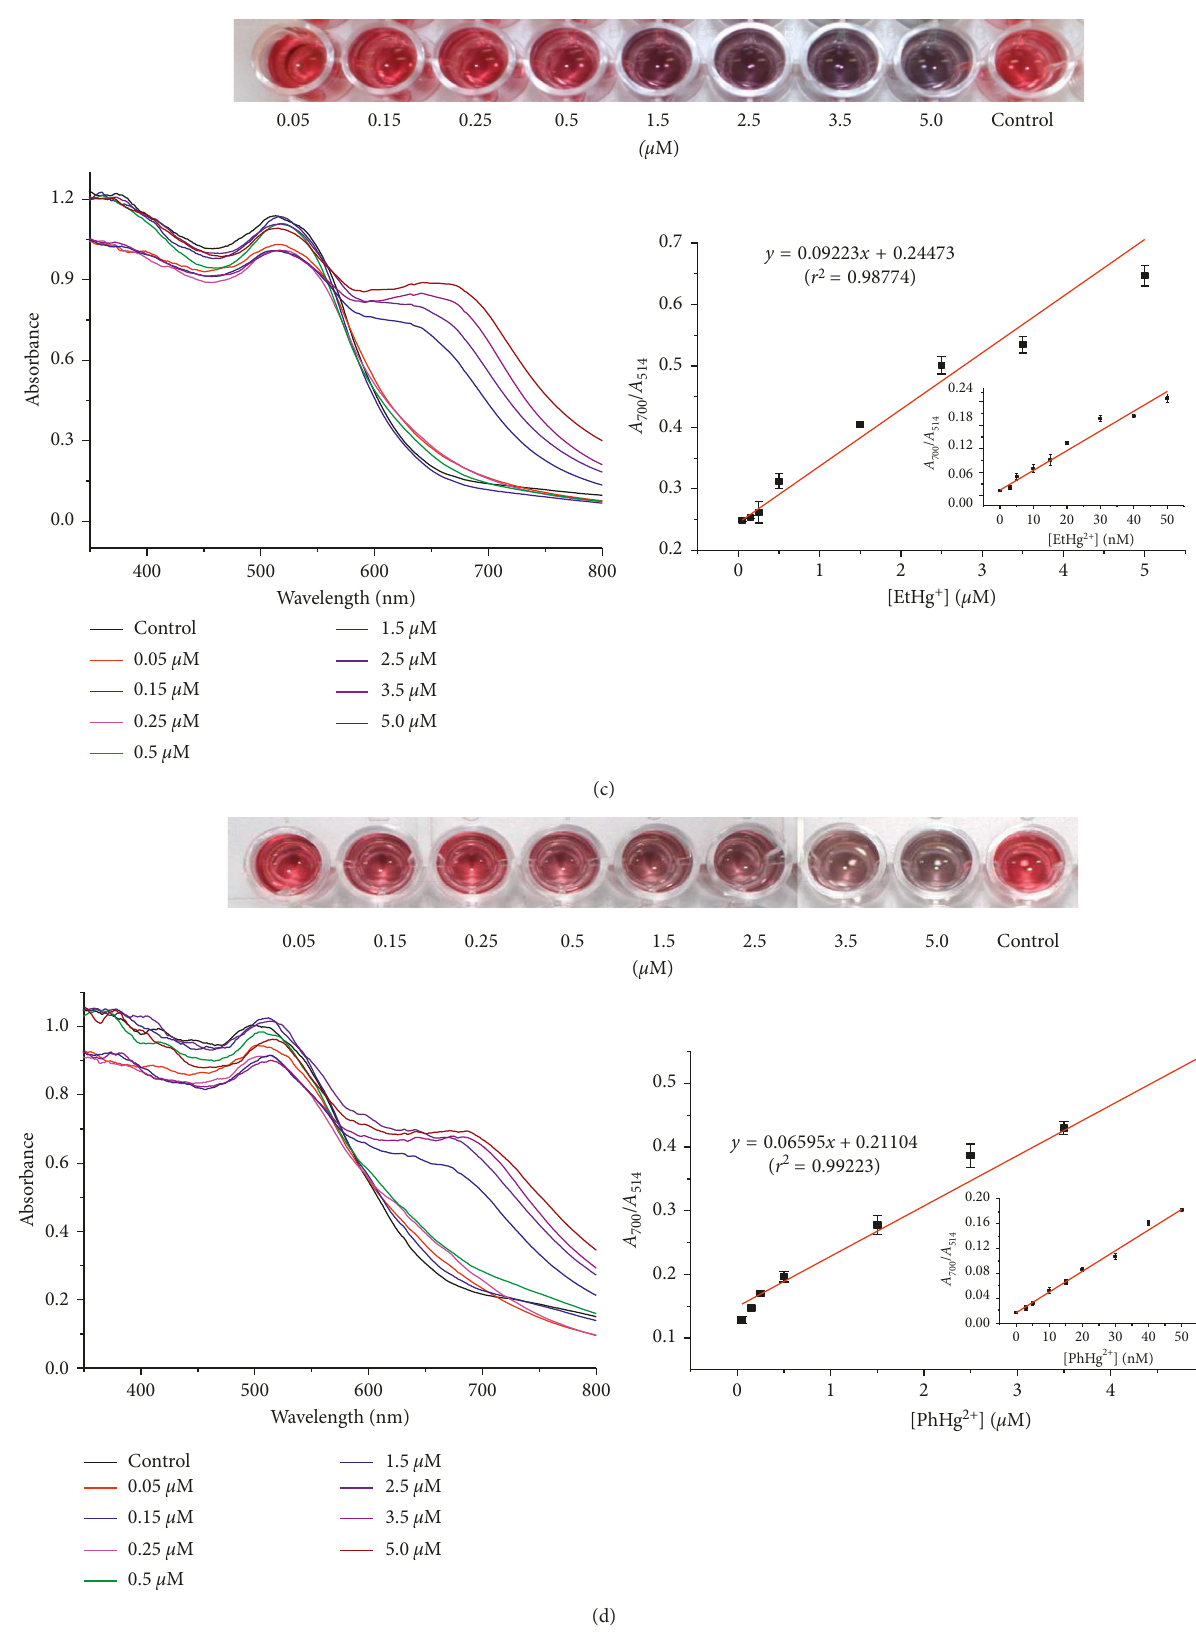
Figure 6: Photographic images, UV-Vis absorption spectra, and absorption ratios ( A 700 / A 514 ) of the color change of PEI-AuNPs upon addition of (a) Hg 2+ , (b) MeHg + , (c) EtHg + , and (d) PhHg + with various concentrations (0.05, 0.15, 0.25, 0.5, 1.5, 2.5, 3.5, and 5.0 μ M from left to right) in the presence of 300mM · NaCl. Inset: plot of A 700 / A 514 versus (a) Hg 2+ , (b) MeHg + , (c) EtHg + , and (d) PhHg + ion concentration